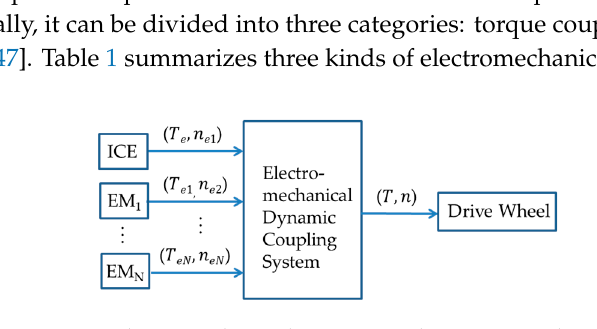
Figure 3. Electromechanical power coupling system schematic. Table 1. Three kinds of electromechanical power coupling systems.